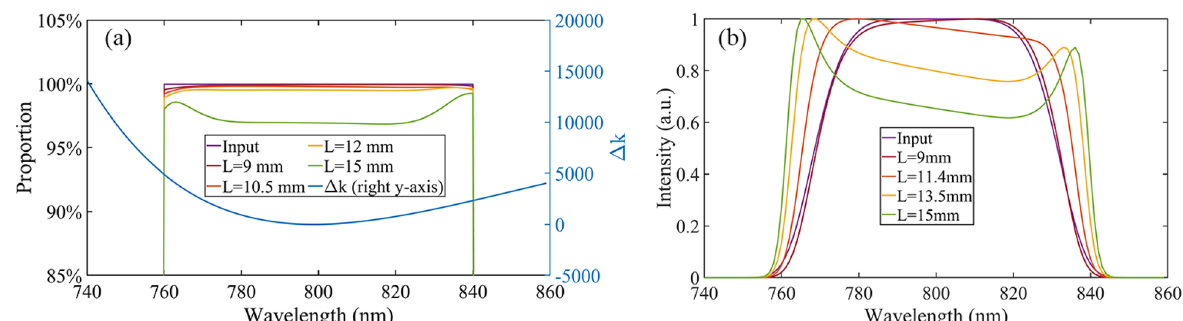
Figure 4. ( a ) OAM spectrums with wavelengths at different crystal lengths (left y-axis) and the value of the wave-vectors mismatch with the wavelength (right y-axis). ( b ) Amplified spectra at different crystal